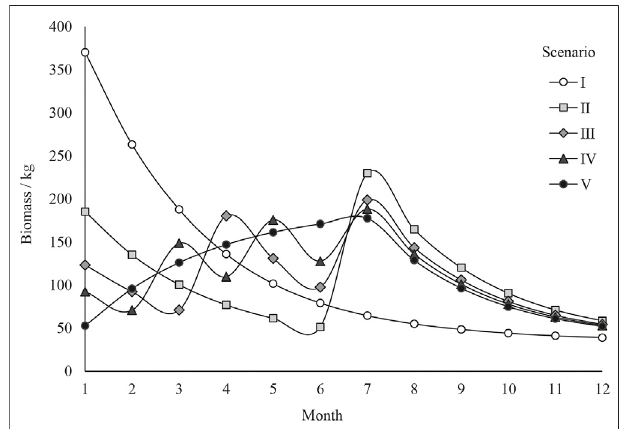
FIGURE 5 | Changes in the number survival of released fi sh under scenarios. Scenario Ito Vindicated that thetotal number of fi sh were released in one, two, three, four, and seven events, respectively, with different intervals during 6